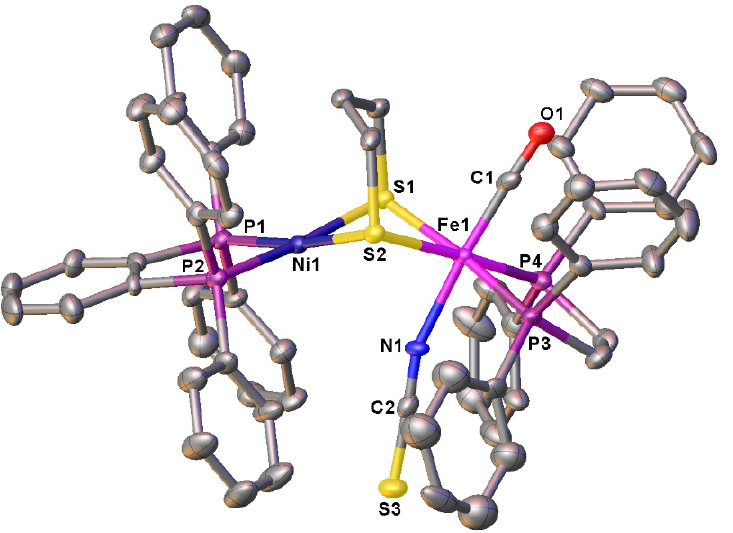
Figure 4. Molecular structure of [ 2 ]BF 4 with thermal ellipsoids drawn at a 30% probability level. All H atoms and one BF 4 − anion are omitted for the sake of clarity. Selected bond lengths (Å) and angles ( ◦ ): Ni ···· Fe 3.1570, Ni1-S1 2.2343(19), Ni1-S2 2.235(2), Fe1-S1 2.3390(19), Fe1-S2 2.3199(18), Fe1-P3 2.232(2), Ni1-P1 2.169(2), C2-N1 1.145(9), C2-S3 1.626(7); S1-Ni1-S2 85.00(7), P1-Ni1-S1 93.09(8), P1-Ni1-P2 89.30(8), S1-Fe1-S2 80.79(6), P3-Fe1-S1 174.89(8), P3-Fe1-P4 86.85(7).